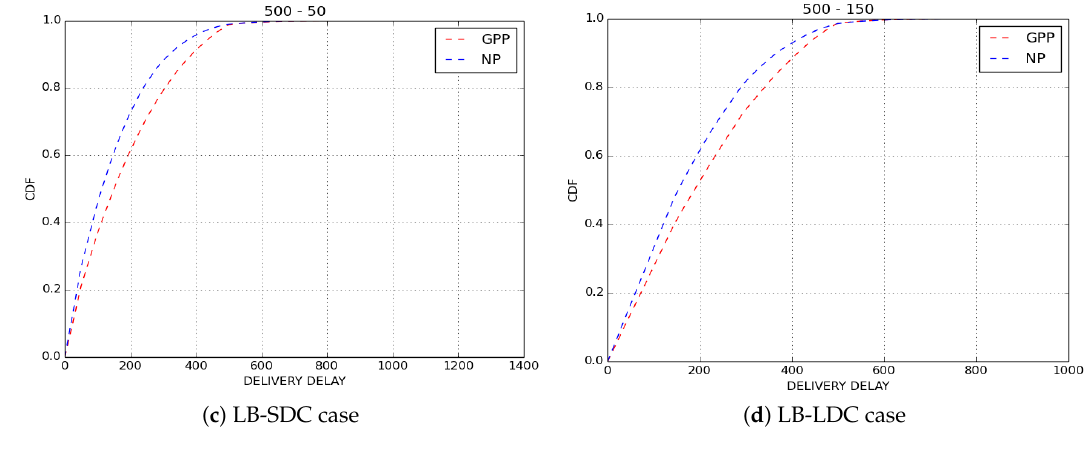
Figure 8. Average delivery